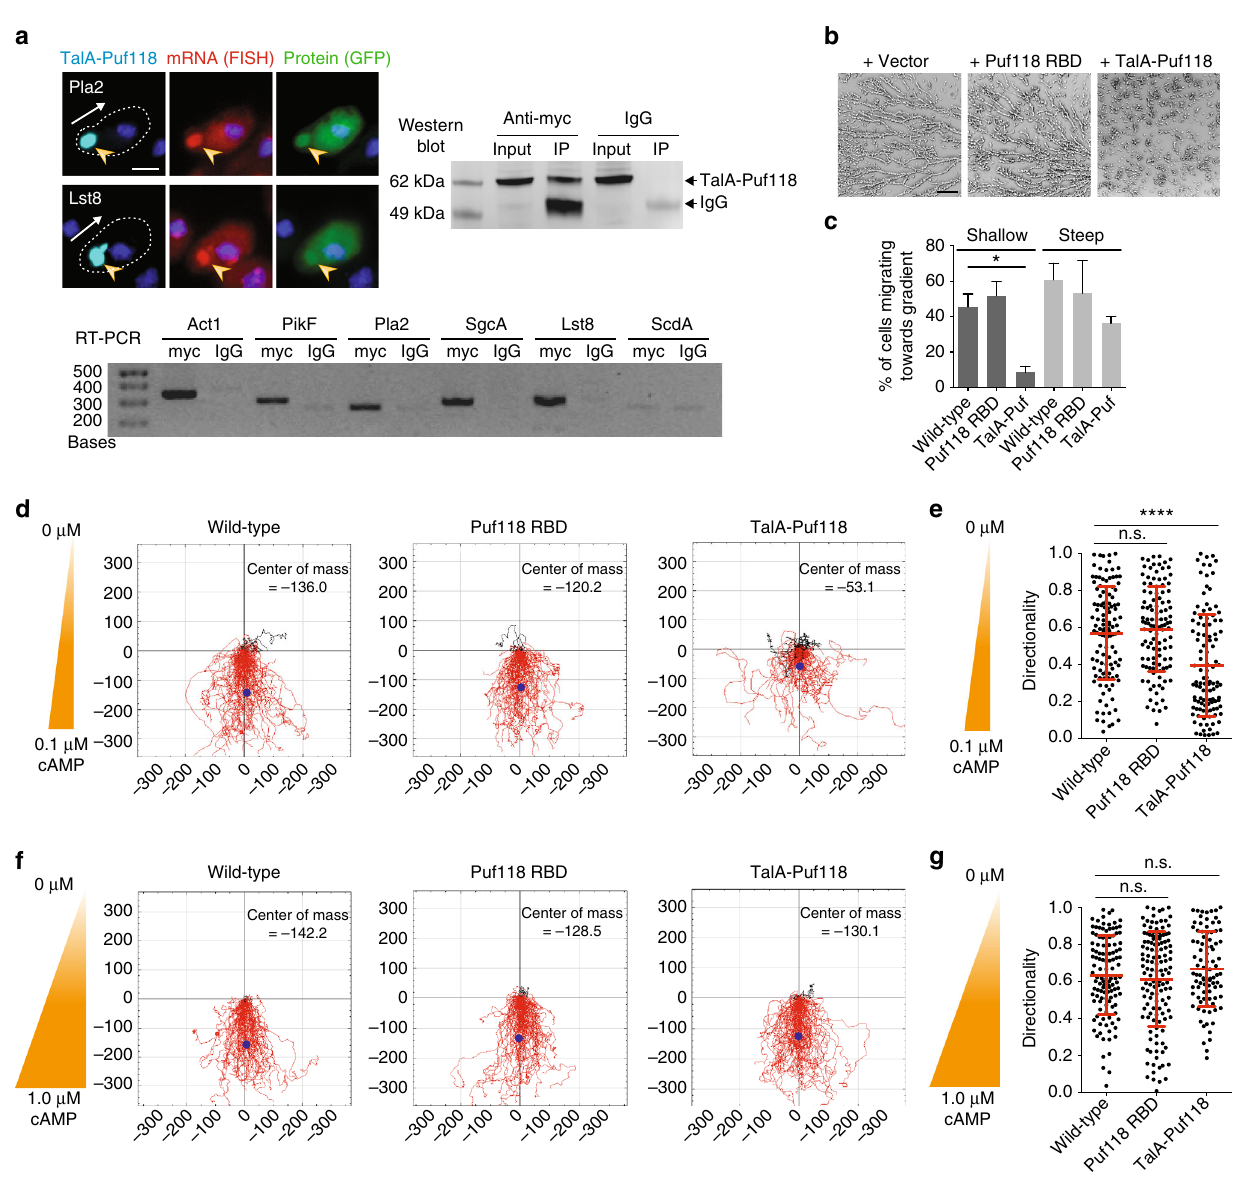
Fig. 4 Mis-localization of Puf118 to the rear of cells inhibits chemotaxis. a Colocalization of GFP-Pla2 and GFP-Lst8 and corresponding mRNAs with myc- tagged TalA-Puf118 (arrowheads) in natural chemotactic streams. Arrow indicates orientation of cell polarity de fi ned by TalA-Puf118 localization. Scale bar, 5 μ m. Myc western blot of myc IPs from lysates of cells expressing TalA-Puf118. RT-PCR of indicated mRNAs coimmunoprecipitated with myc-TalA-Puf118. Mouse IgG was used as an immunoprecipitation control. b Chemotactic streams of cells expressing vector control, Puf118-RBD or TalA-Puf118 after starvation for 15 h. Scale bar, 300 μ m. c Percent of wild-type cells, cells expressing Puf118-RBD or TalA-Puf118 migrating towards a 0.1 µ M/mm (shallow) or 1 µ M/mm (steep) cAMP gradient during 180 min. Mean and SD of n ≥ 3 experiments; Mann – Whitney test: * p < 0.05. d – g Tracks ( d , f ) and directionality ( e , g ) of wild-type cells, cells expressing Puf118-RBD or TalA-Puf118 migrating in a chemotaxis chamber for 180 min in a 0.1 µ M/mm (shallow; d , e ) or 1 µ M/mm (steep; f , g ) cAMP gradient. n ≥ 110 cells from ≥ 3 independent experiments. Mann – Whitney test: **** p < 0.0001, n.s. not signi fi